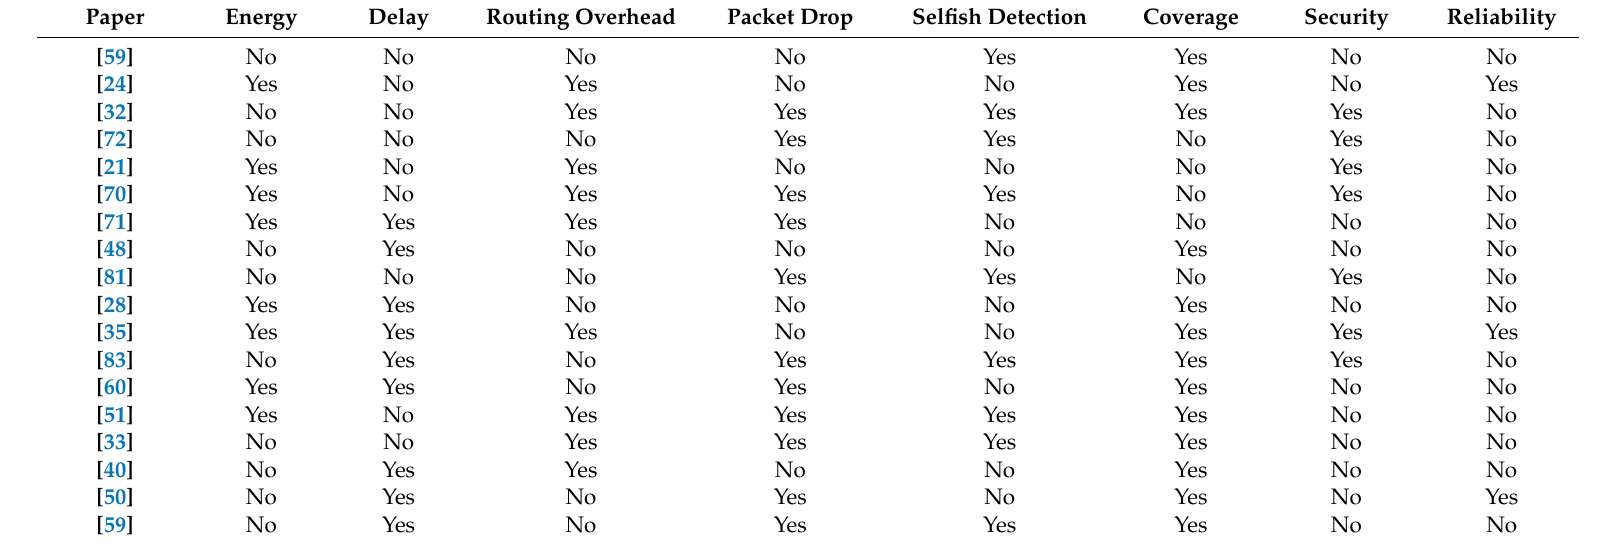
Table 3. Evaluation and comparison of the approaches based on the performance metrics